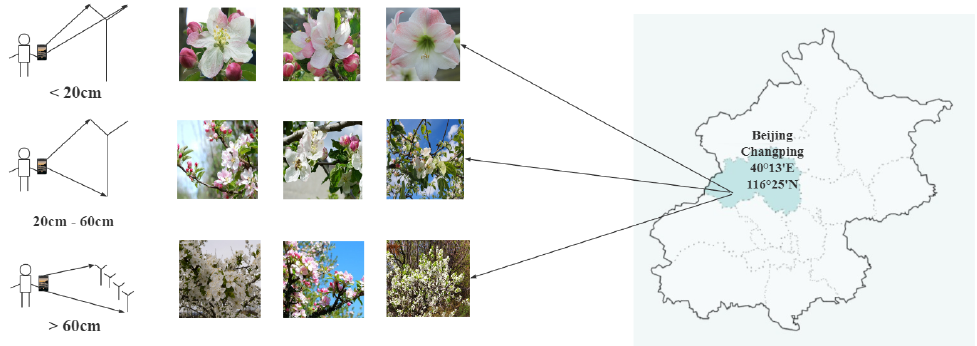
Figure 1. Image dataset was collected in Taolin Village in three scales.